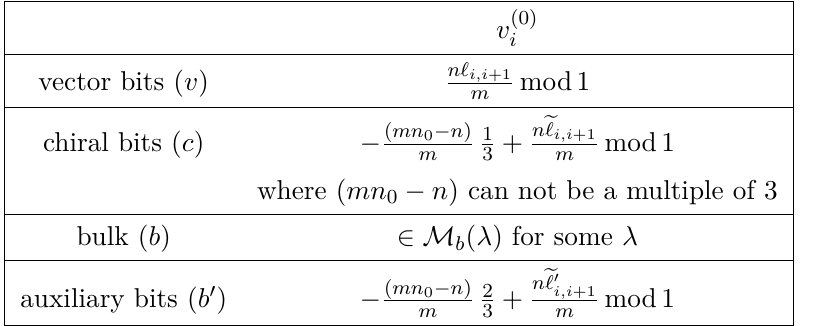
Table 1 . The positions of vector, chiral, auxiliary bits and the bulk. The seeds in positions b are to be integrated over the bulk of the original integration contour. They define the integration variables entering, for instance, in the integrals (1.17). The factors of I ( v by the relations depicted in figure 1, the sum-rules (1.34) and (1.35). They are the ones labelled by the ( i, j ) that are assigned to the letter b . These factors I ( v integral